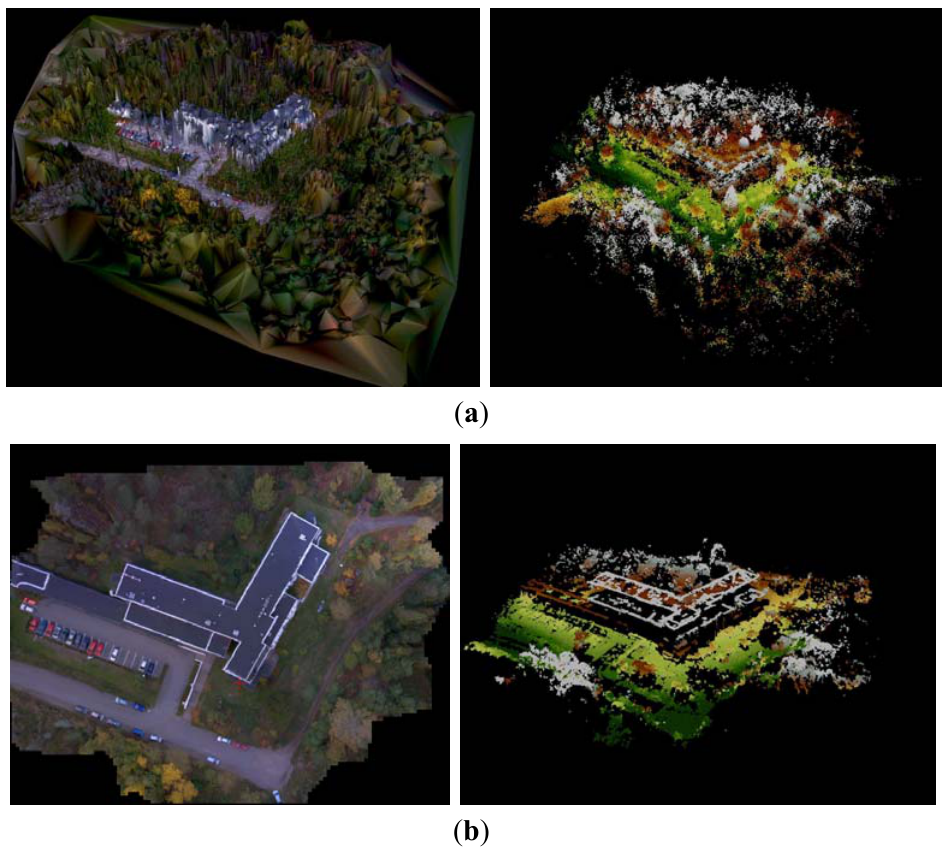
Figure 13. Point clouds from the FGI main building provided by ( a ) Photosynth ( left : RGB, right : earth tones) and ( b ) NGATE ( left : image mosaic, right : point cloud in earth tones). In point clouds the black areas are without